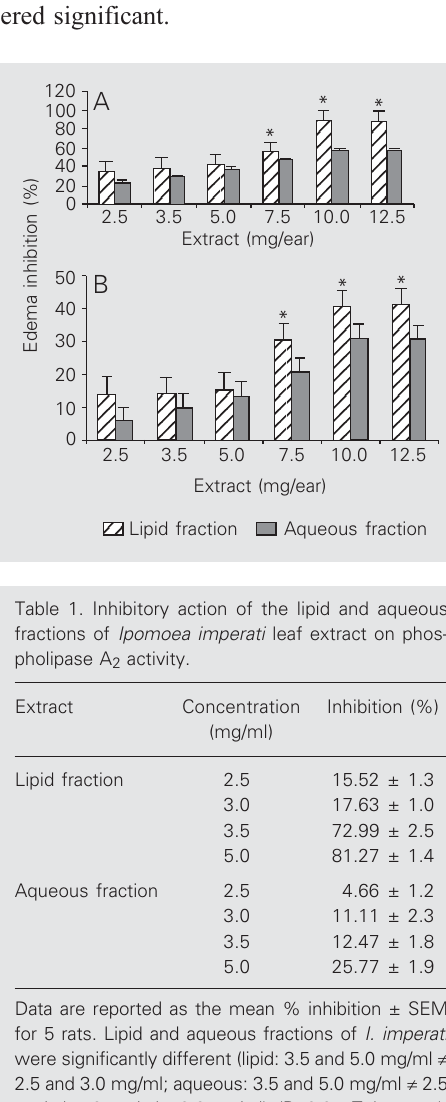
Data are reported as the mean % inhibition ± SEM for 5 rats. Lipid and aqueous fractions of I. imperati were significantly different (lipid: 3.5 and 5.0 mg/ml (cid:1) 2.5 and 3.0 mg/ml; aqueous: 3.5 and 5.0 mg/ml (cid:1)